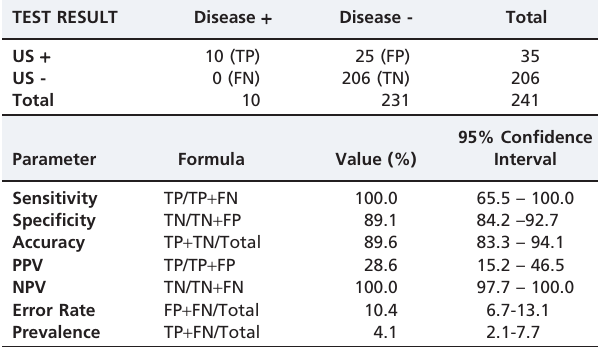
Table 3 - Diagnostic performance of